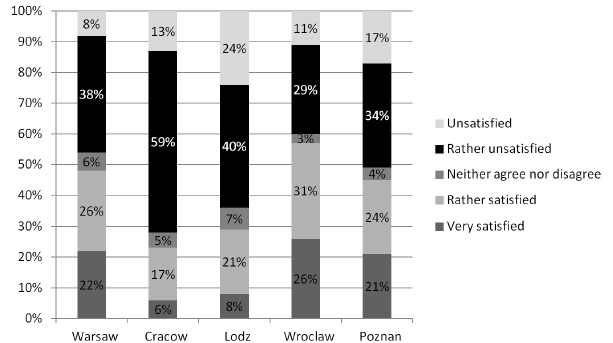
Figure 2. Air quality assessment in the biggest Polish cities 2018.